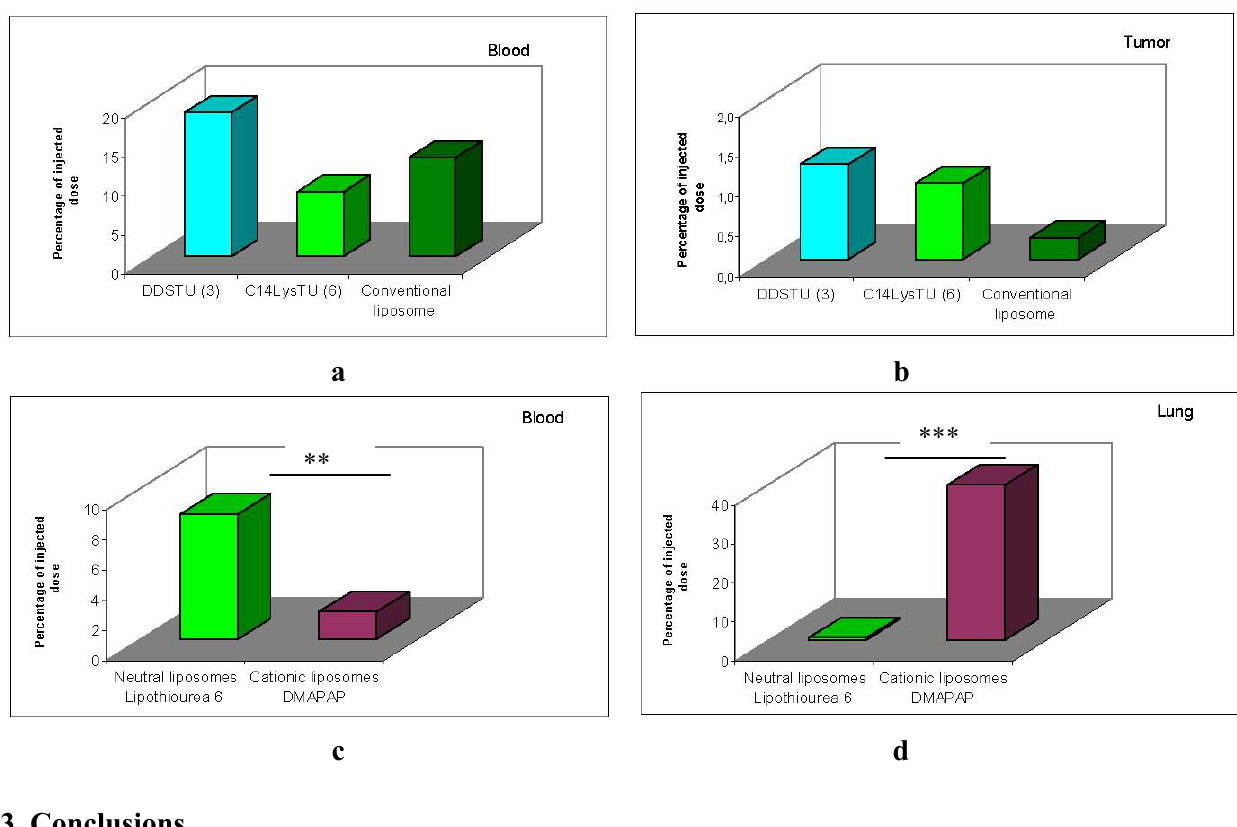
Figure 8. Biodistribution in C57BL\6 mice of rhodamine labelled lipothiourea (LT) 3 and 6 as compared to conventional liposomes in blood ( a ); and 3LL subcutaneous tumors ( b ) 2 h post i.v. injection. Biodistribution in C57BL\6 mice of rhodamine labelled lipothiourea 6 as compared to cationic liposomes in blood ( c ); and in lung ( b ) 2 h post i.v. injection. Labelled lipids were extracted from the blood or the organs and the rhodamine level measured in the extracts as previously reported [38,48] Statistics were performed with